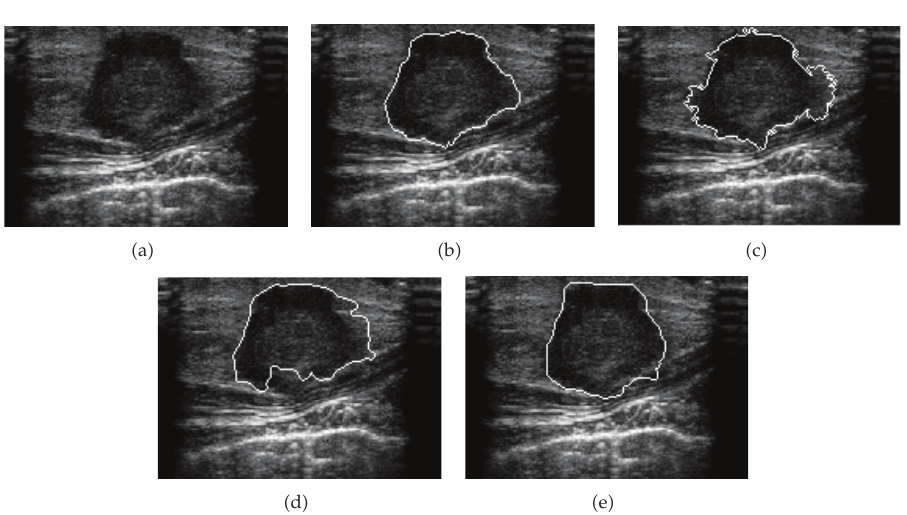
Figure 8: Segmentation of a malignant breast tumor intensity inhomogeneity and low contrast. (cid:3) a (cid:4) Original image. (cid:3) b (cid:4) Golden standard. Segmentation results of (cid:3) c (cid:4) GAC (cid:5) 11 (cid:6) , (cid:3) d (cid:4) DRLSE (cid:5) 16 (cid:6) , and (cid:3) e (cid:4) the proposed PGBLSE models.